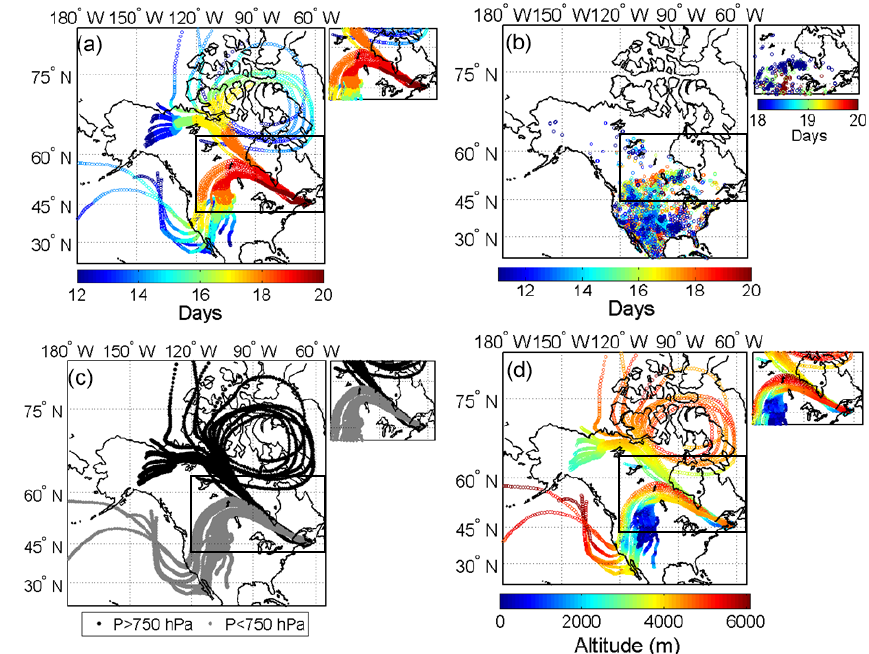
Figure 6. (a) Temporal position (express as day from 12 to 20 July) along the 200h back trajectories. (b) Spot of the biomass burning fires derived from the FLAMBE archive as function of the day in which they occurred (from 11 to 20 July – we selected the dataset at 13:00 and the 23:00UTC). (c) Back trajectories for starting points along the flight trajectories at P >750hPa (black) and P <750hPa (grey). (d) Altitude along the back